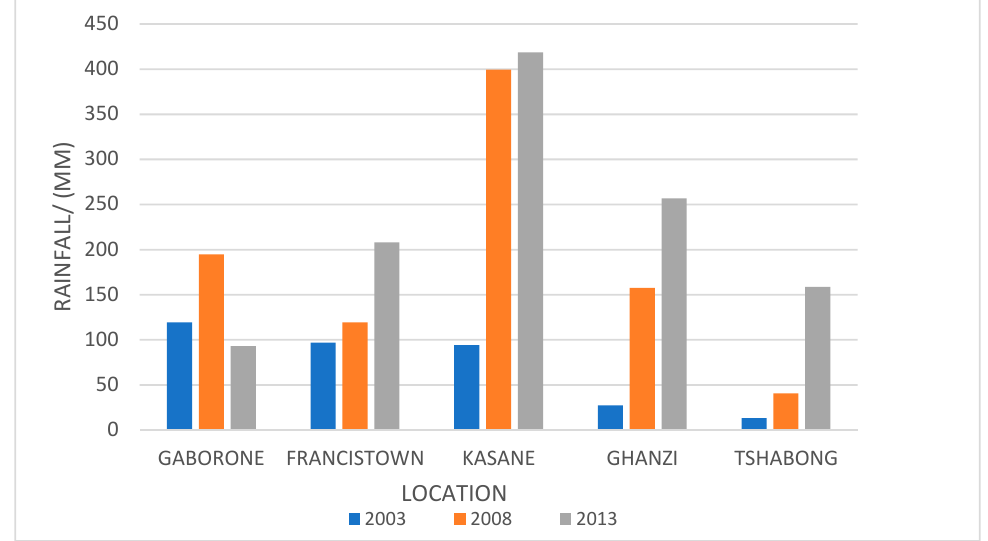
Figure 2. Rainfall amount (mm) in Botswana over five stations between 2003, 2008 and 2013 (Source: DMS)